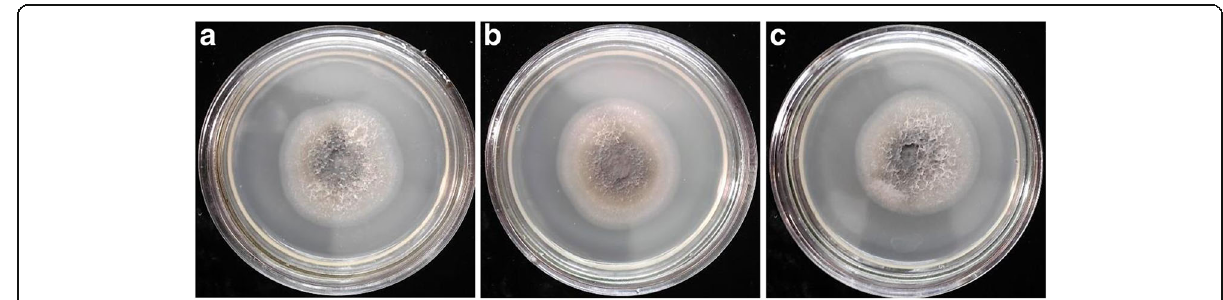
Fig. 5 P. herpotrichoides colonies, grown on PDA (a 7th day culture) with the addition of silver or copper nanoparticles: a control (without nanoparticles); b PDA media with Ag nanoparticles; c PDA media with Cu